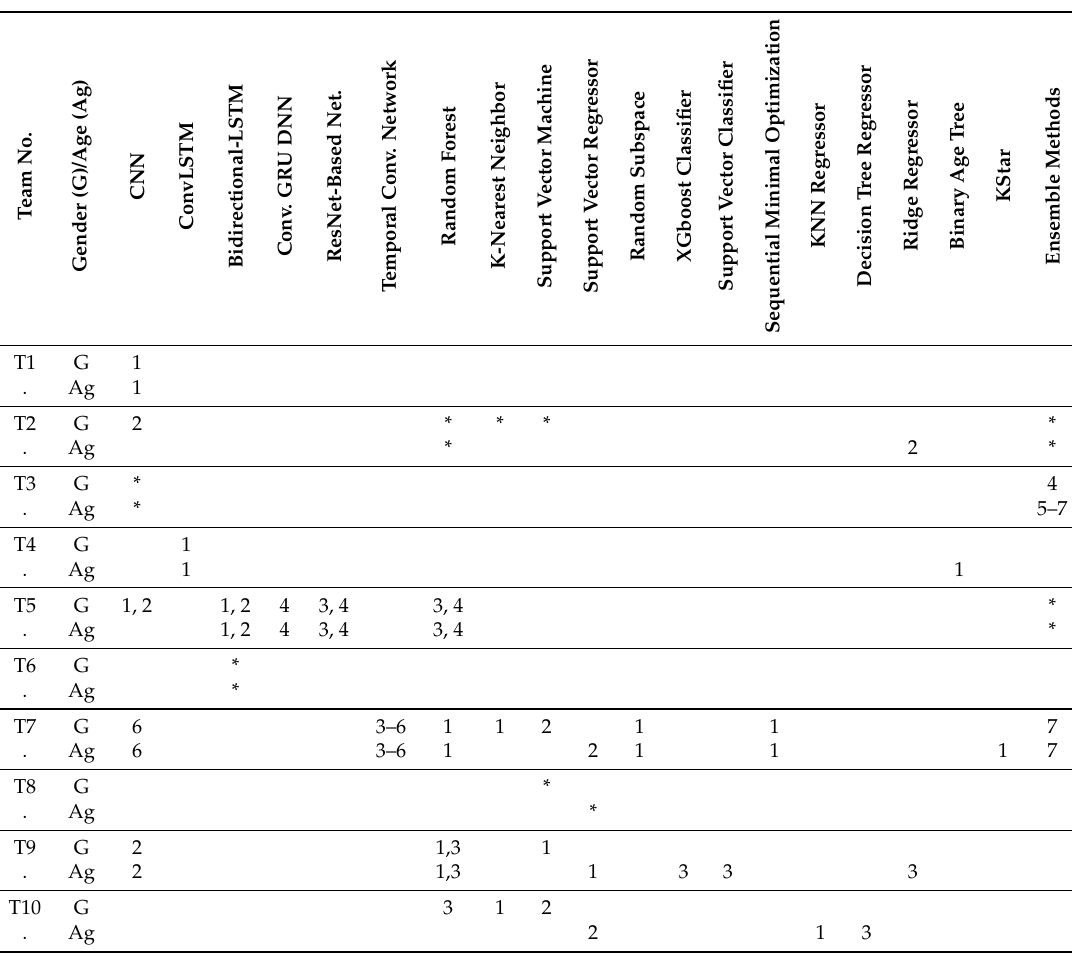
Table 5. Classifiers for gender (G) classification and age (Ag) prediction. ‘*’ denotes that all of their algorithms used the approach. Numbers represent the algorithm numbers per